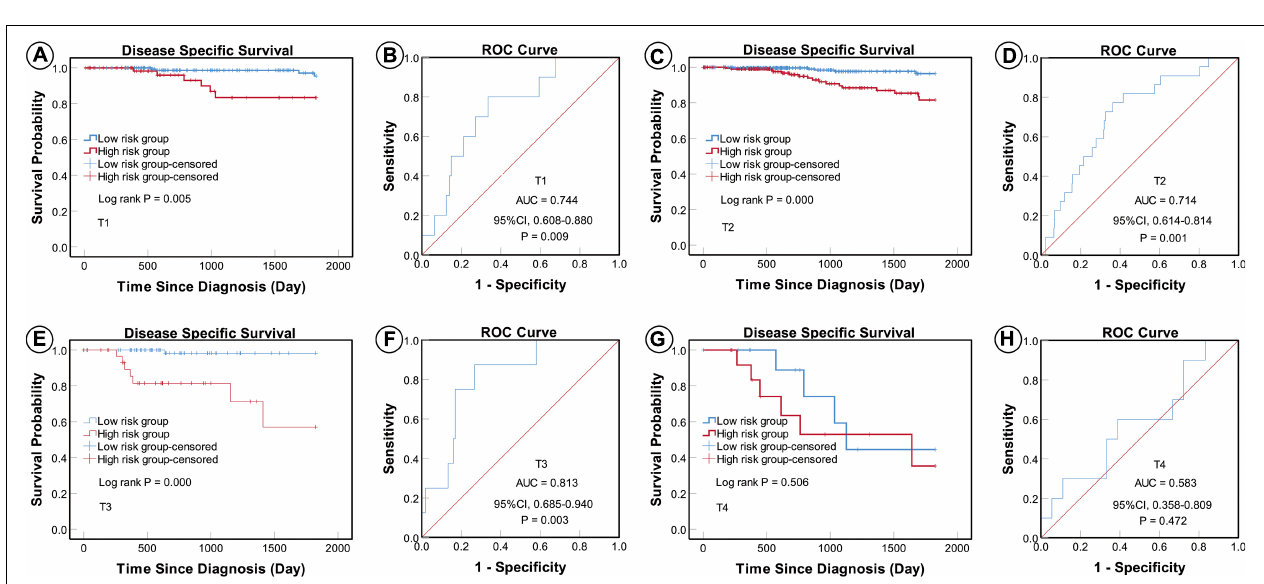
FIGURE 5 | KM and ROC curves for patients stratified by lymph node status. KM analysis showed that patients in the low-risk group had significantly better DSS in the N0 (A) , N1 (C) , N2 (E) , and N3 (G) subgroups. ROC analysis showed that the five-miRNA signature exhibited high sensitivity and specificity in predicting the prognosis of patients with BC in the N0 (B) , N1 (D) , N2 (F) , and N3 (H) subgroups.